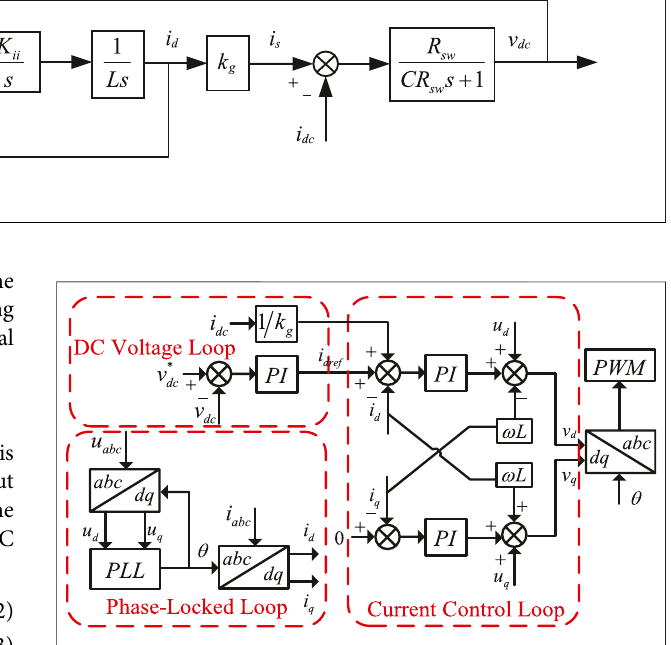
FIGURE 6 | Topology diagram of the control system.